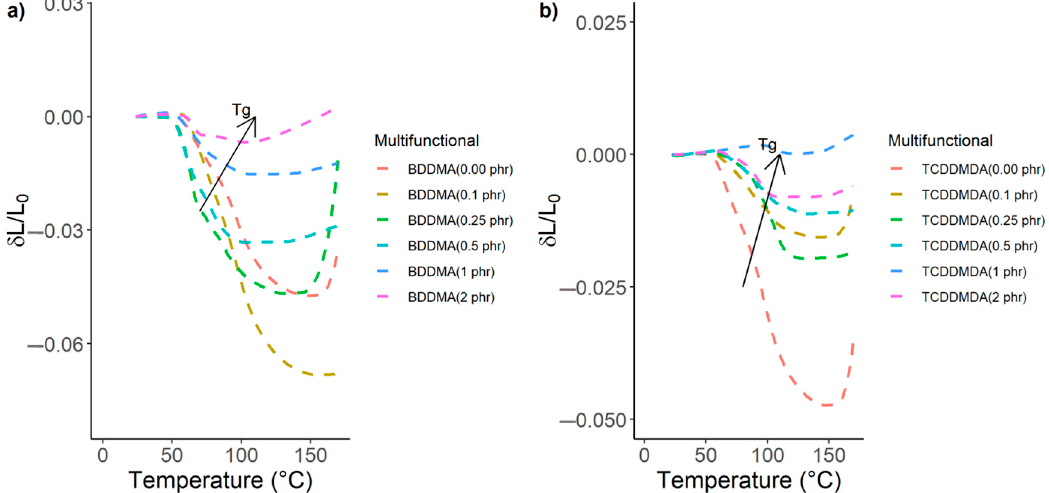
Figure 5. Dilatometry curves of Elium ® composites for both multifunctional methacrylate monomers. Black arrows show the increasing trend in T g : ( a ) butanediol-di-methacrylate (BDDMA) and ( b ) tricyclo-decane-dimethanol-di-methacrylate (TCDDMDA).